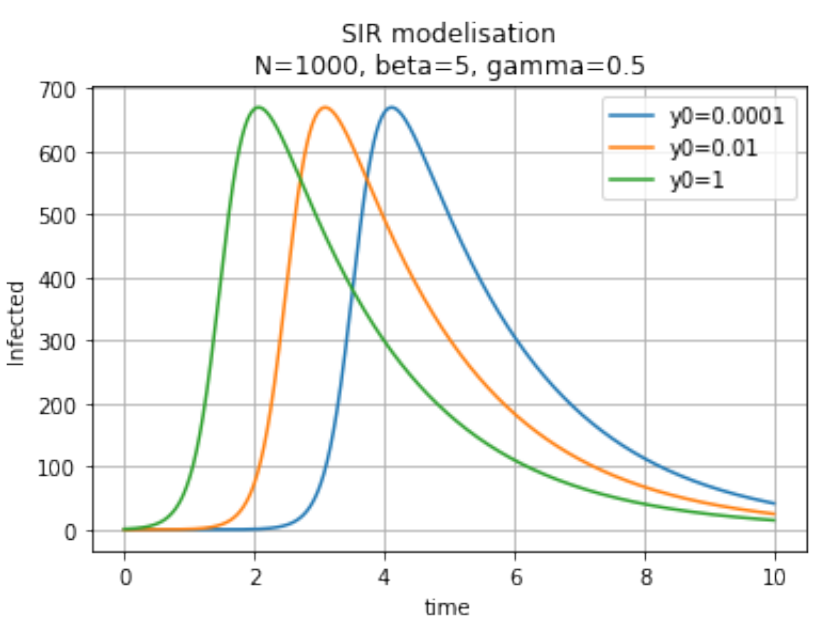
Figure 2. Infectious individuals I ( t ) for different initial